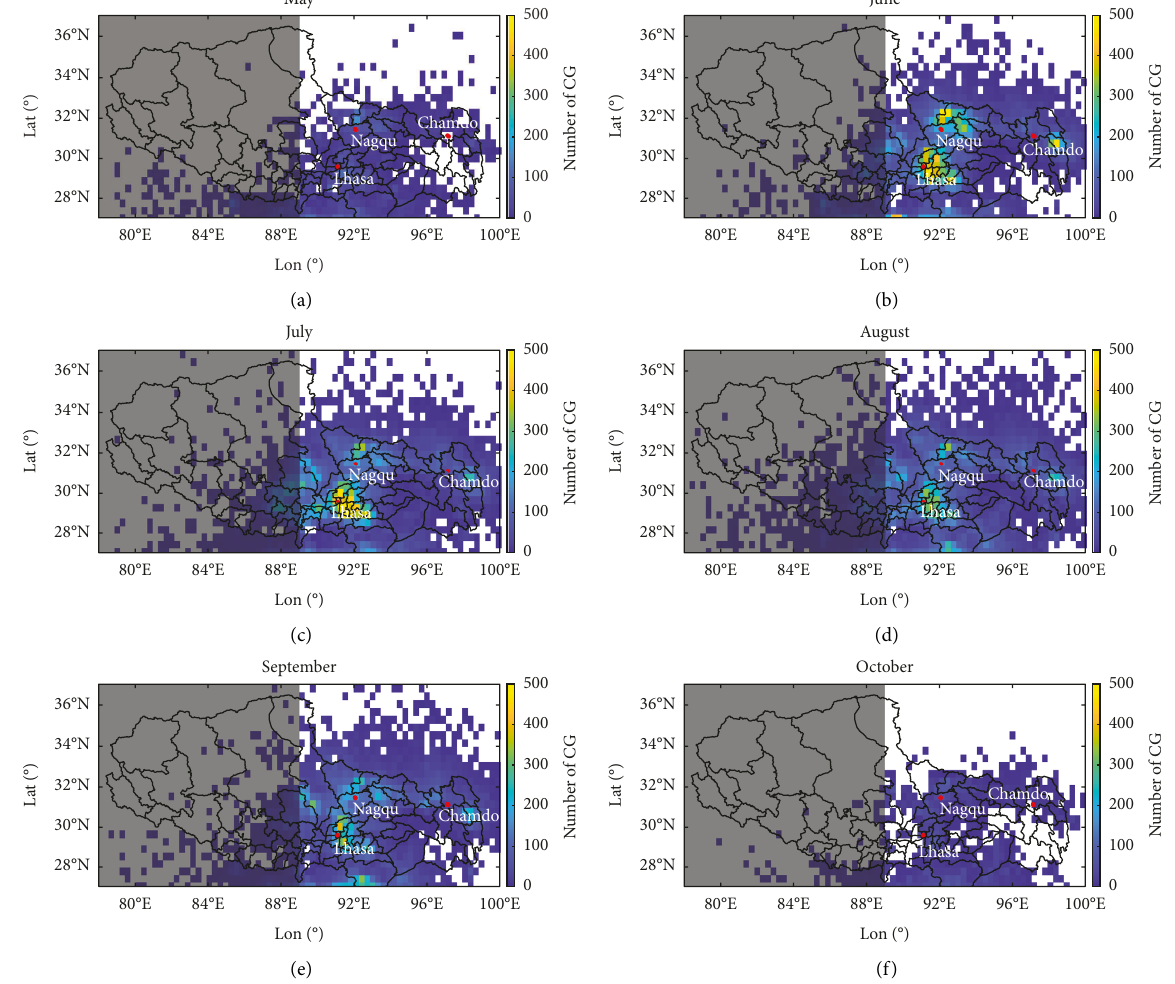
Figure 5: (a–f) Average distribution of CG lightning from May to October, respectively, during